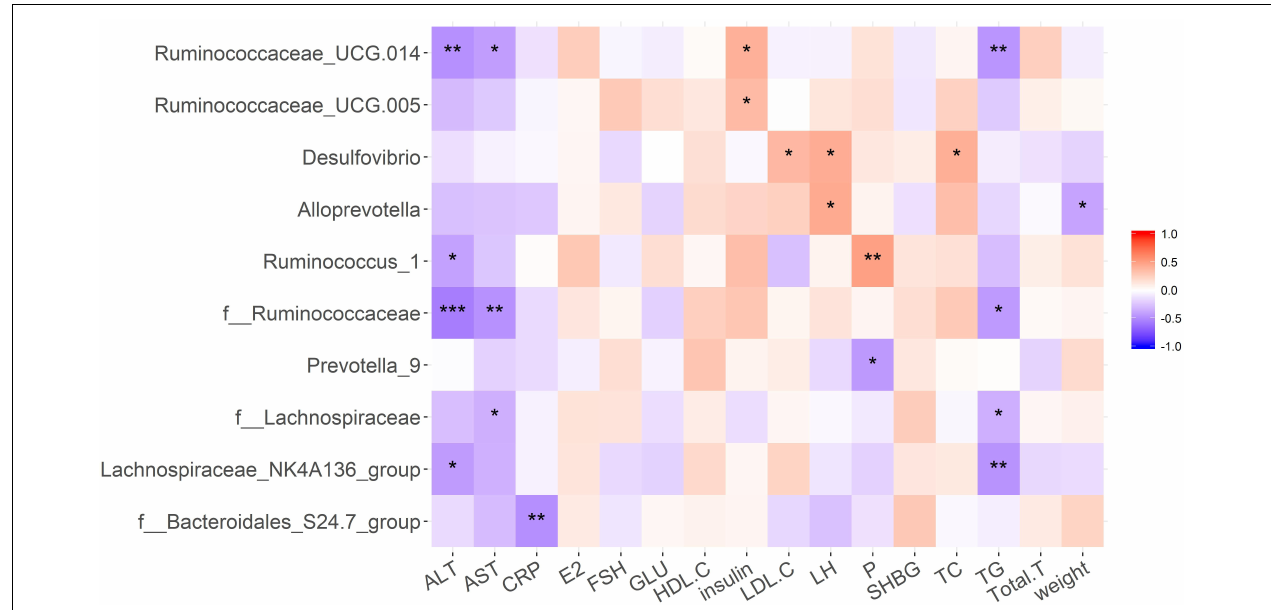
FIGURE 7 | Pearson correlation analysis was performed to determine the correlation between clinical phenotypes and gut microbiota in each group. ∗ p < 0.05, ∗∗ p < 0.01, ∗∗∗ p <